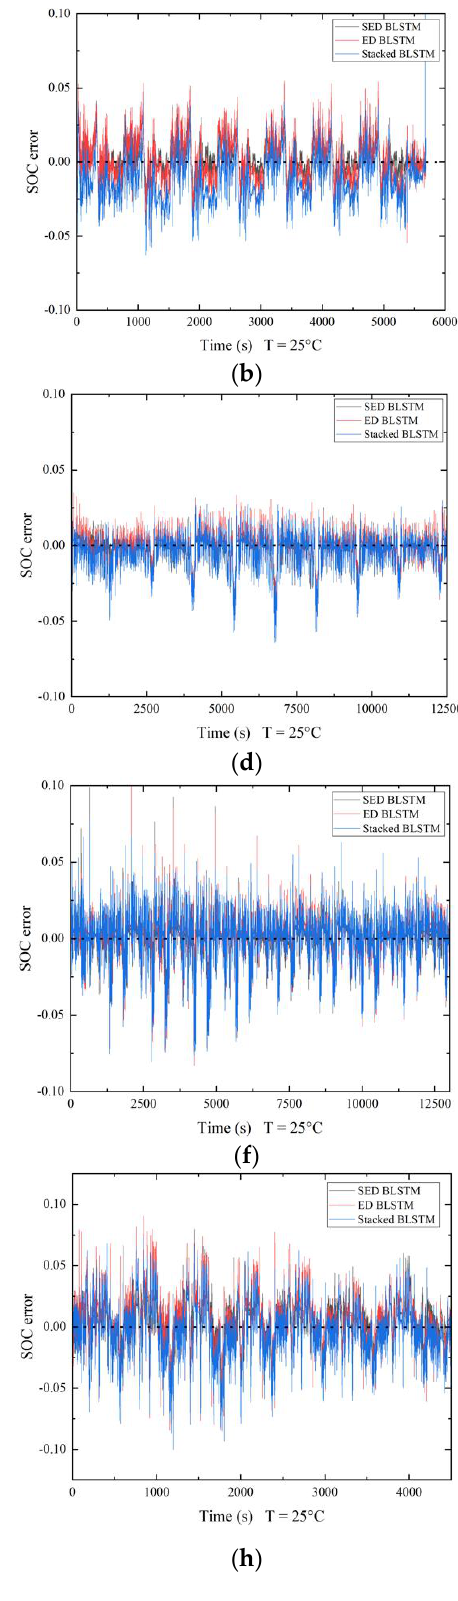
Figure 8. Predicted SOC comparison and SOC prediction error at 25 ◦ C. ( a , b ) HWFET. ( c , d ) UDDS. ( e , f ) LA92. ( g , h ) US06.